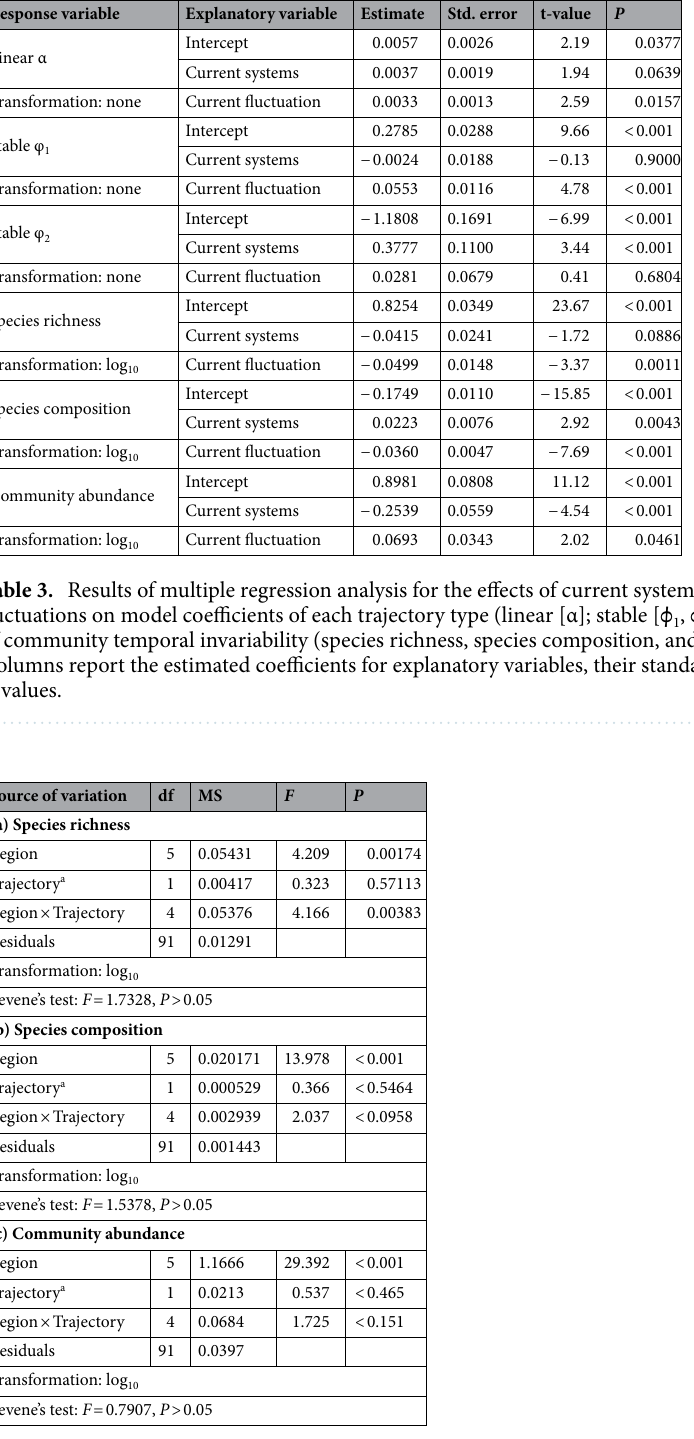
Table 4. Results of two-way ANOVA for the effects of region and trajectory (linear or stable) a on three measures of community temporal invariability (species richness (a), species composition (b), and community abundance (c)). a Please see main text for a description of community